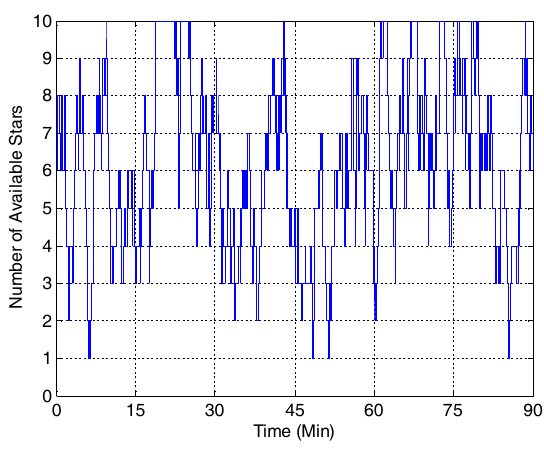
Figure 1. Number of available stars.